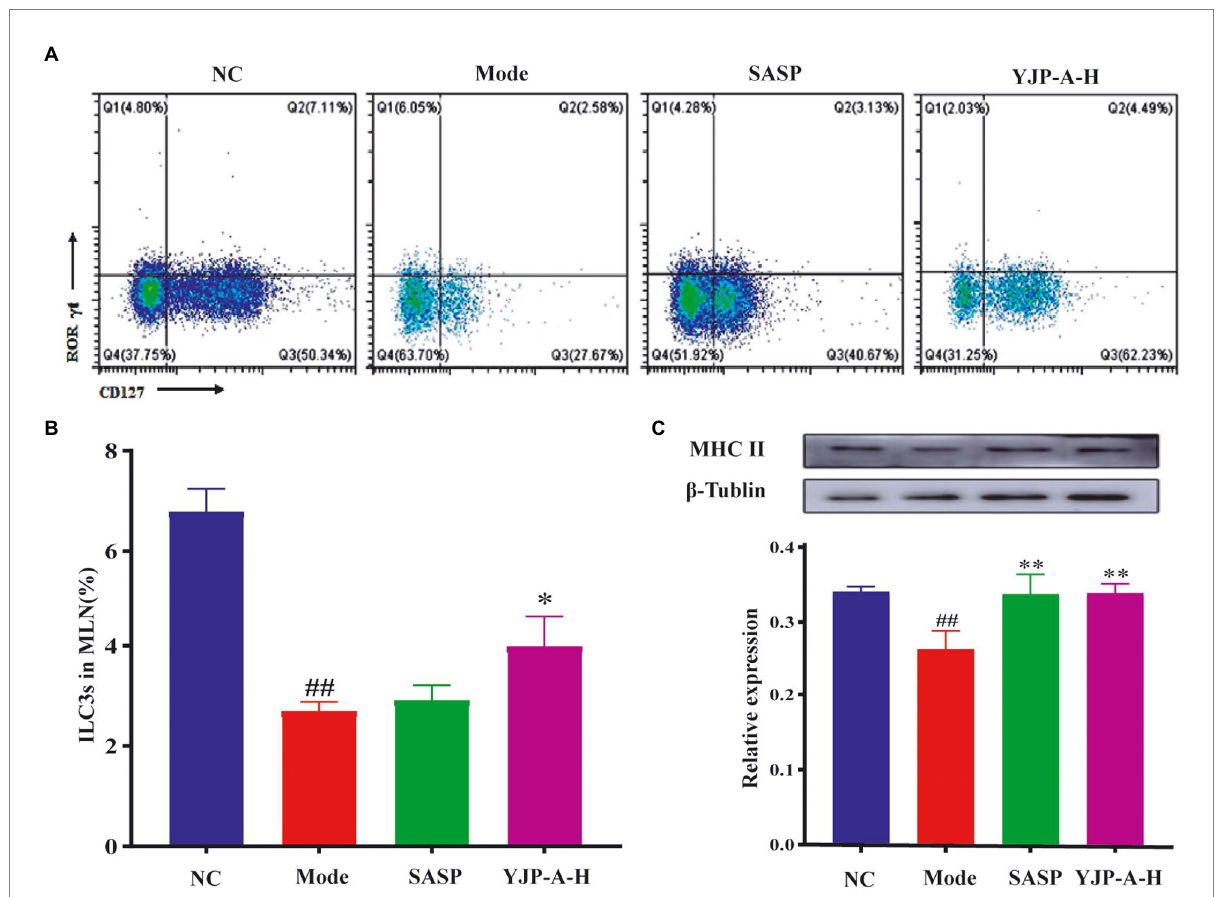
FIGURE 4 Effects of YJP-A-H on changes of ILC3s (A, B) , and MHC II expression levels (C) in MLNs. Data are expressed as the mean ± SEM, except for flow cytometry assay n = 3 per group, the remaining analysis n = 5 per group. ## p < 0.01, vs. NC group; * p < 0.05, ** p < 0.01 vs. model